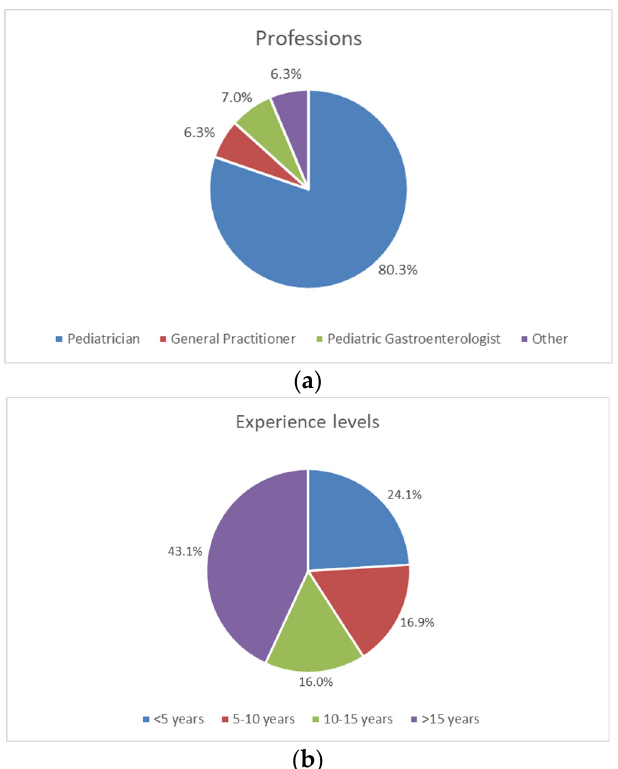
Figure 2. Demographics of the respondents. ( a ) Percentage by profession. ( b ) Percentage by years of experience.